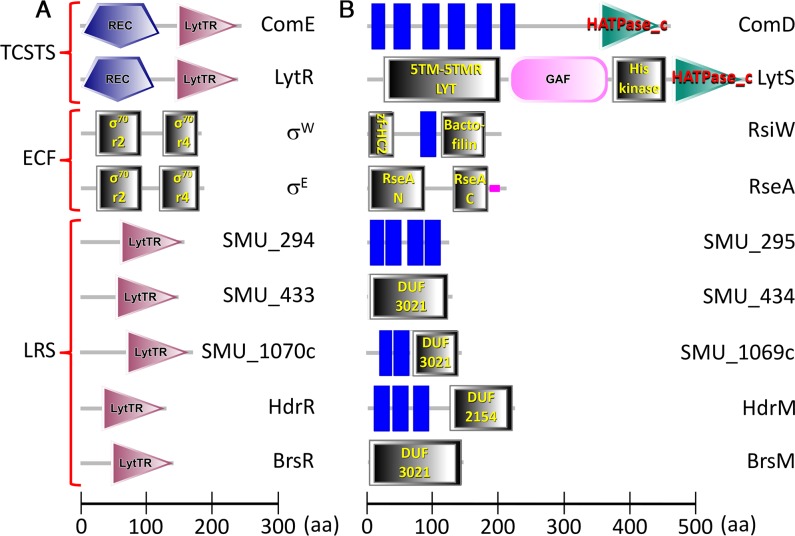
LRS are distinct from TCSTS and ECF systems.A) Comparison of the domain architectures of TCSTS response regulators, ECF σ factors, and LRS regulators. The illustrated proteins are from S. mutans with the exception of σW (B. subtilis) and σE (E. coli) and are all drawn to scale. Individual protein domains are labeled accordingly. B) Comparison of the domain architectures of TCSTS sensor kinases, ECF anti-σ factors, and LRS membrane proteins. The illustrated proteins are from S. mutans with the exception of RsiW (B. subtilis) and RseA (E. coli) and are all drawn to scale. Individual protein domains are labeled accordingly. Blue rectangles indicate transmembrane segments that are not located within identified conserved protein domains. All proteins were illustrated and annotated using the SMART webserver (http://smart.embl-heidelberg.de) [63].